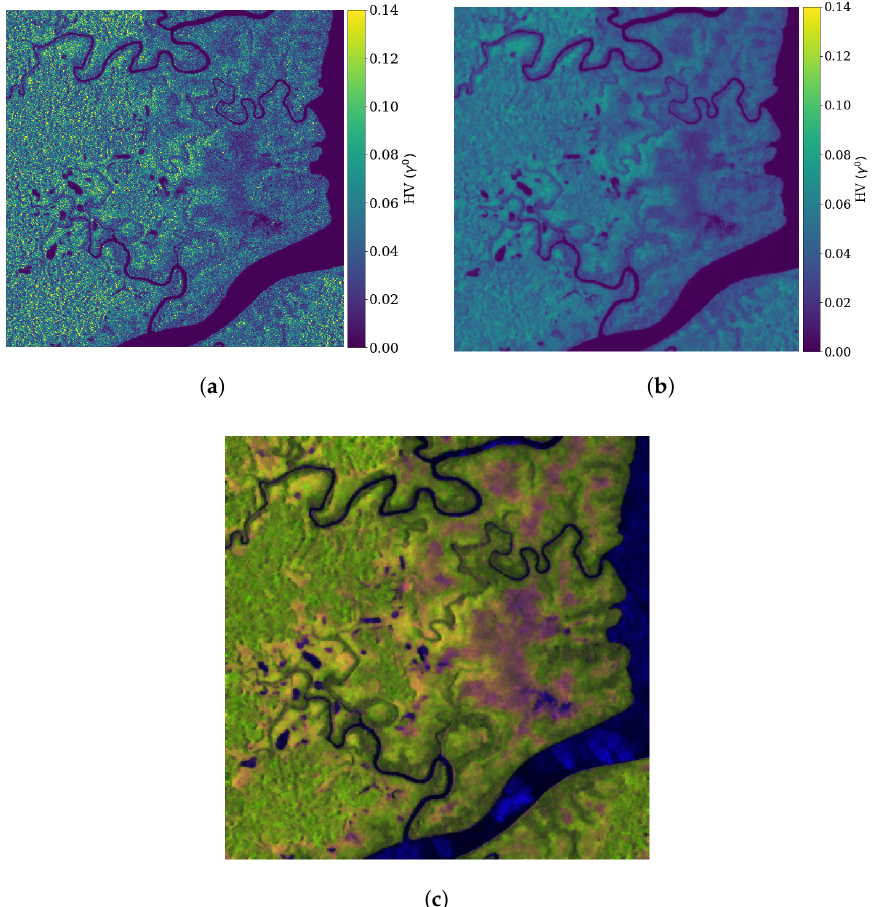
Figure 3. Top row: PALSAR-2 HV backscatter image over a subset of Mondah that ( a ) has been RTC-ed and ( b ) additionally despeckled with total variation. Bottom row: ( c ) the RGB product used for segmentation and estimation. Red is HH, green HV, and blue the polarization ratio HH/HV. All of the polarizations are in linear γ 0 ; each RGB channel is scaled to [ 0,1 ]